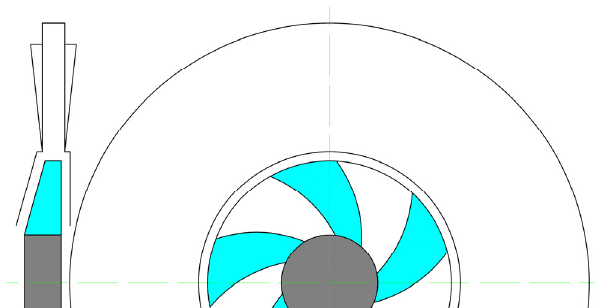
Figure 3. Bladeless diffuser—radial fan.